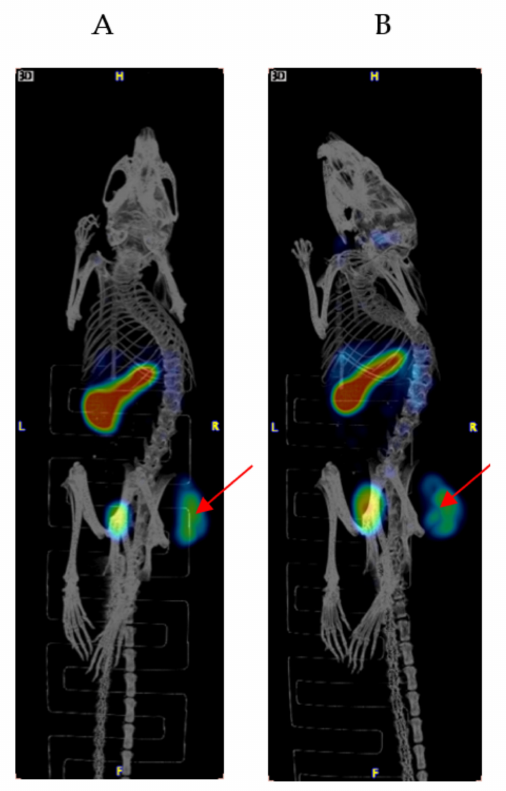
Figure 2. MicroSPECT/CT imaging of a female SCID mouse bearing canine-patient-derived Gracie tumors injected via IV with 111 In-IF3 mAb to IGF2R. ( A ) 24 h post-injection; ( B ) 48 h post-injection. The uptake in the tumors and spleen and excretion through the bladder are seen. Red arrows are pointing to the